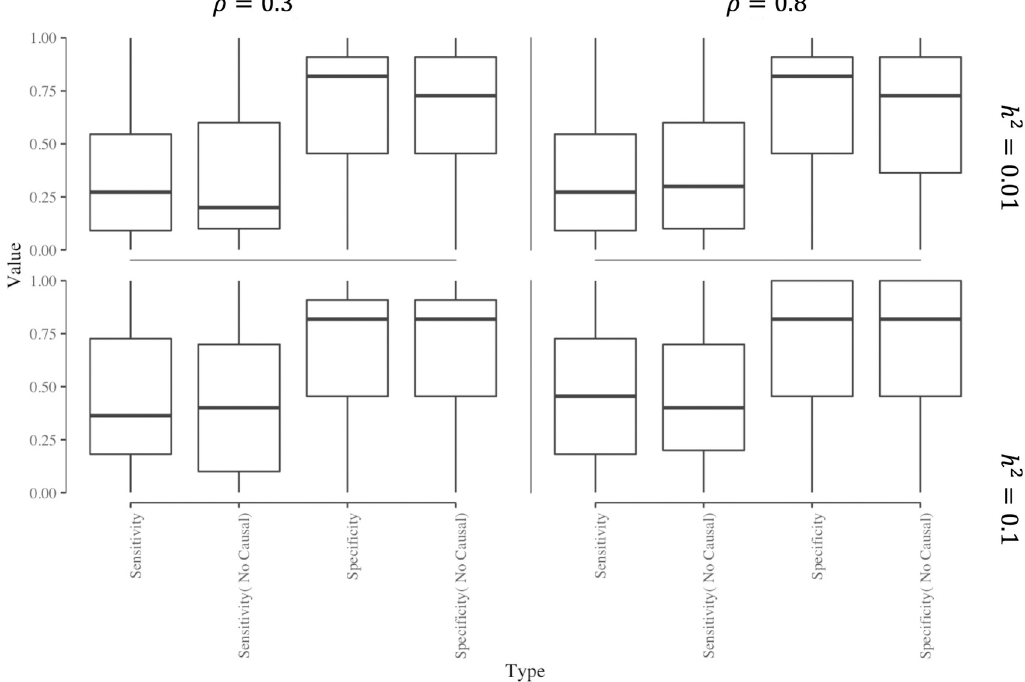
Fig 4. Sensitivity and Specificity of sCCA features. The box plot of sensitivity and specificity of sCCA putting non-zero weights on the tissue where genotype regulates gene expression. We varied underlying gene expression heritability ( h 2 ) and correlation ( ρ ) with the causal tissue as: (a) h 2 = 0.01, ρ = 0.3; (b) h 2 = 0.01, ρ = 0.8; (c) h 2 = 0.1, ρ = 0.3; (d) h 2 = 0.1, ρ = 0.8.